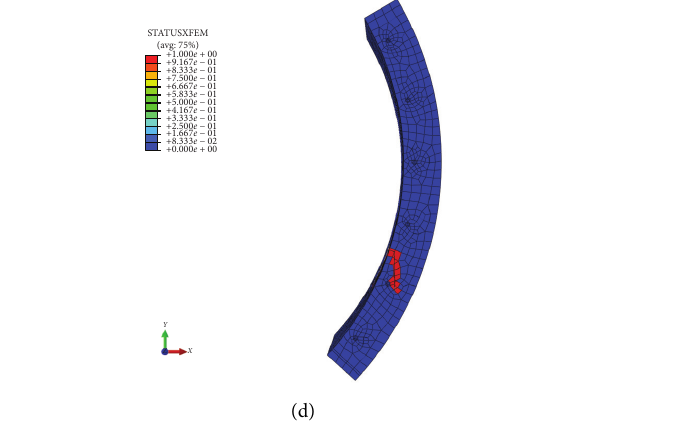
Figure 8: The final crack in the shield segment under different train speeds: (a) 100km/h; (b) 80km/h; (c) 60km/h; (d) 40